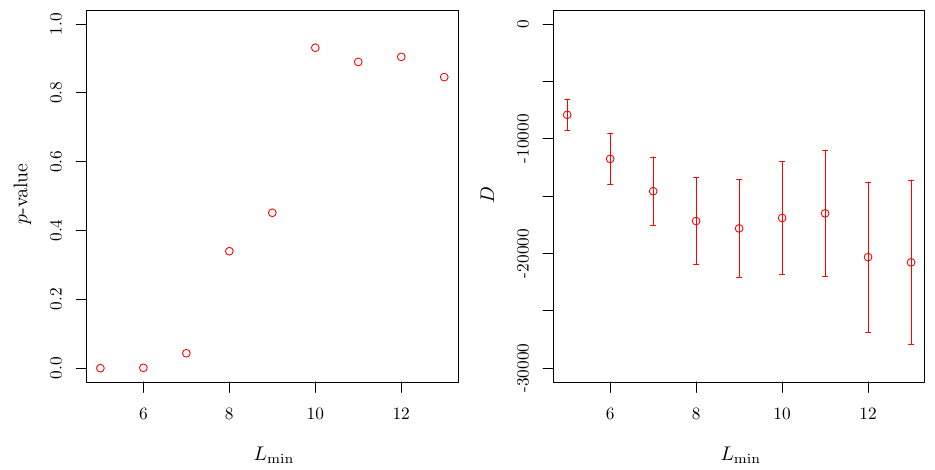
Fig. 10 p value and D as functions of L min from fits of Eq. (21) to the data of (cid:7) E